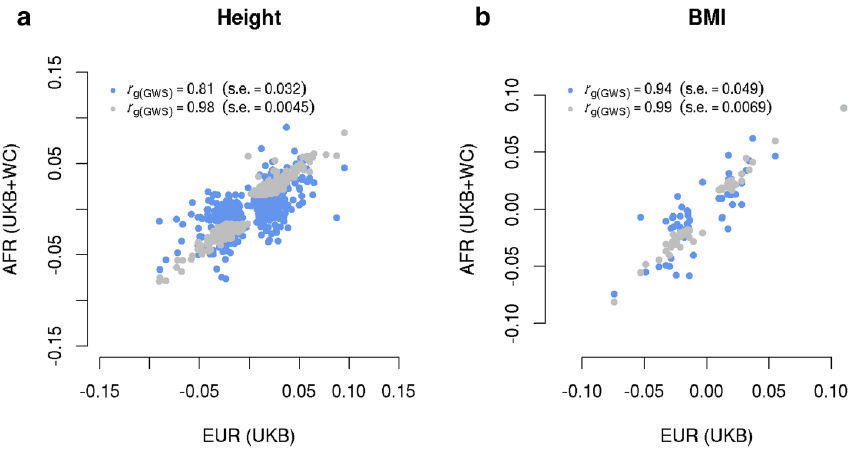
Figure 1. Estimated genetic effect correlation between AFR and EUR for height ( a ) and BMI ( b ) at genome- wide significant SNPs. The near-independent trait-associated SNPs were discovered in GIANT with their effects re-estimated in our EUR ( n = 456, 422 ) and AFR ( n = 23, 355 ) data. The blue dots show a comparison of SNP effects between EUR and AFR and the grey ones show the comparison within EUR (i.e., GIANT vs.